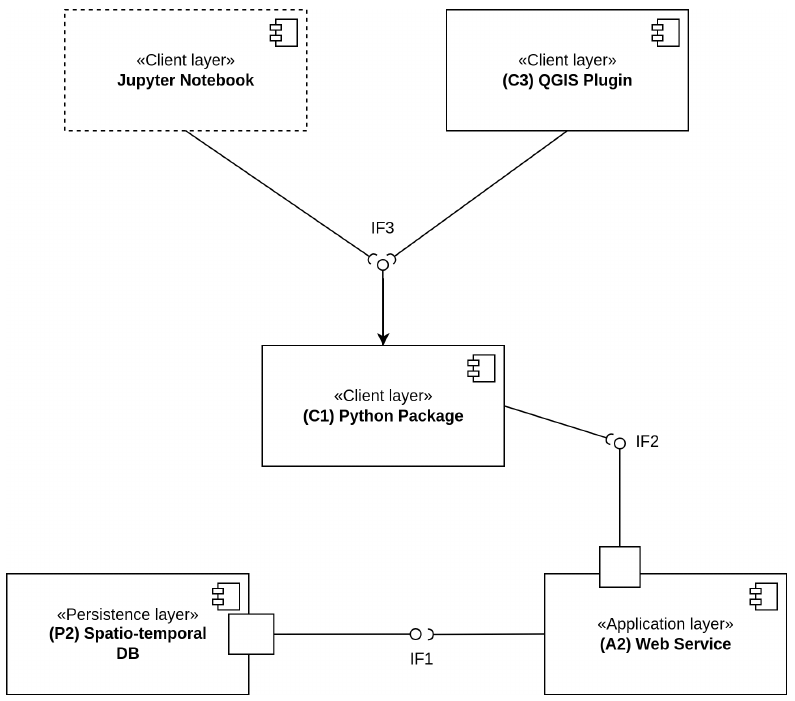
Figure 4. ST_LUCAS system software components with defined